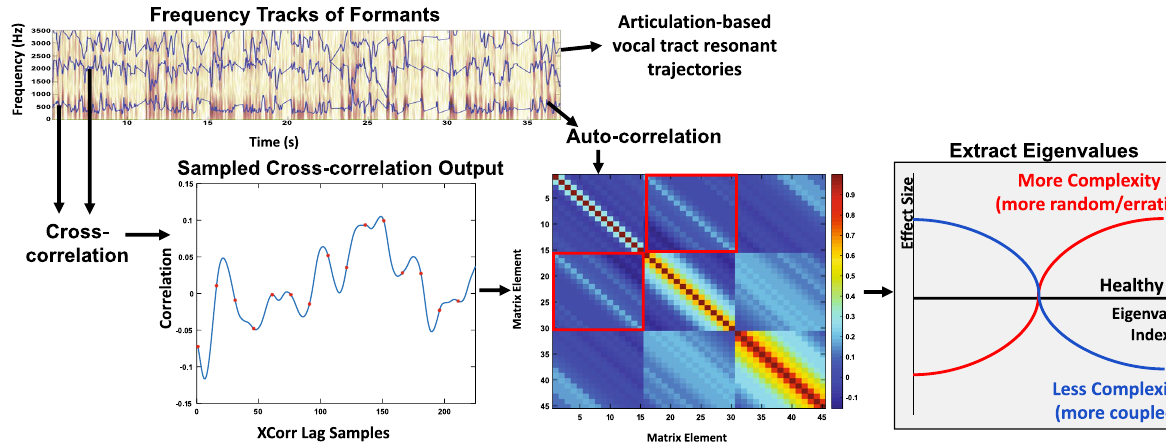
Figure 6. Correlation-based feature extraction. Process of extracting correlation based features through a correlation matrix technique. The patterns of eigenvalues provide insight into the relative complexity of the underlying